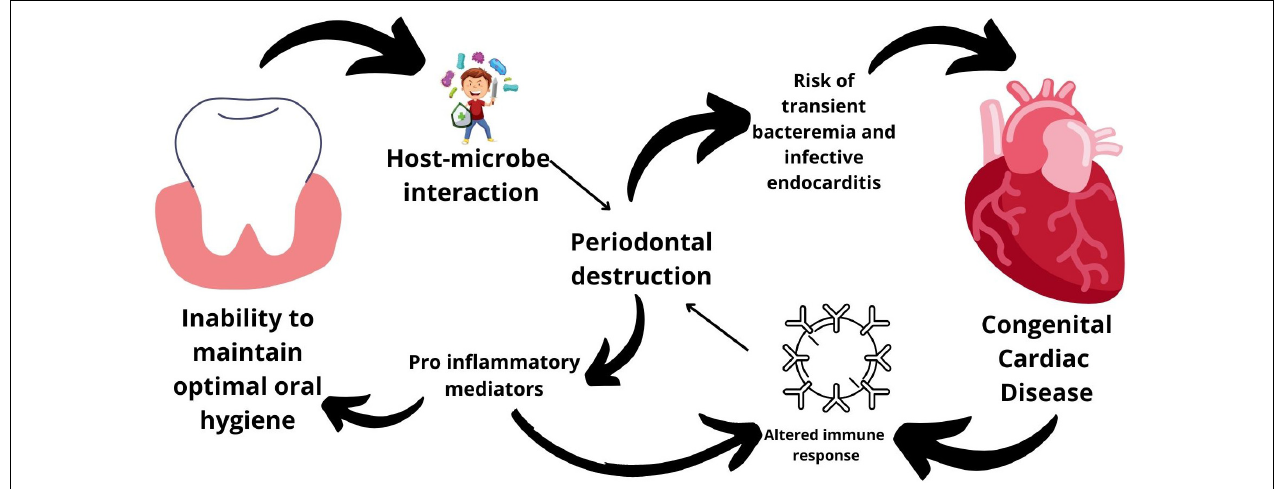
FIGURE 1 | Mechanisms linking periodontal disease and congenital heart